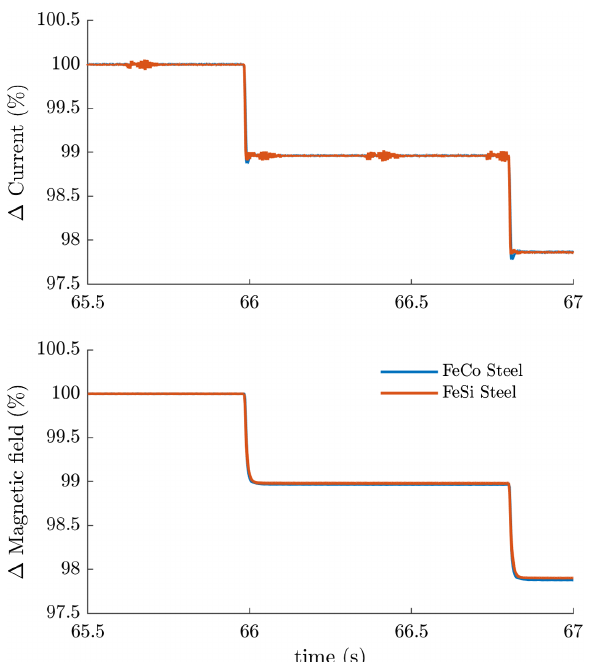
FIG. 21. Low current step. Top: current normalized and bottom: variation of the field normalized.